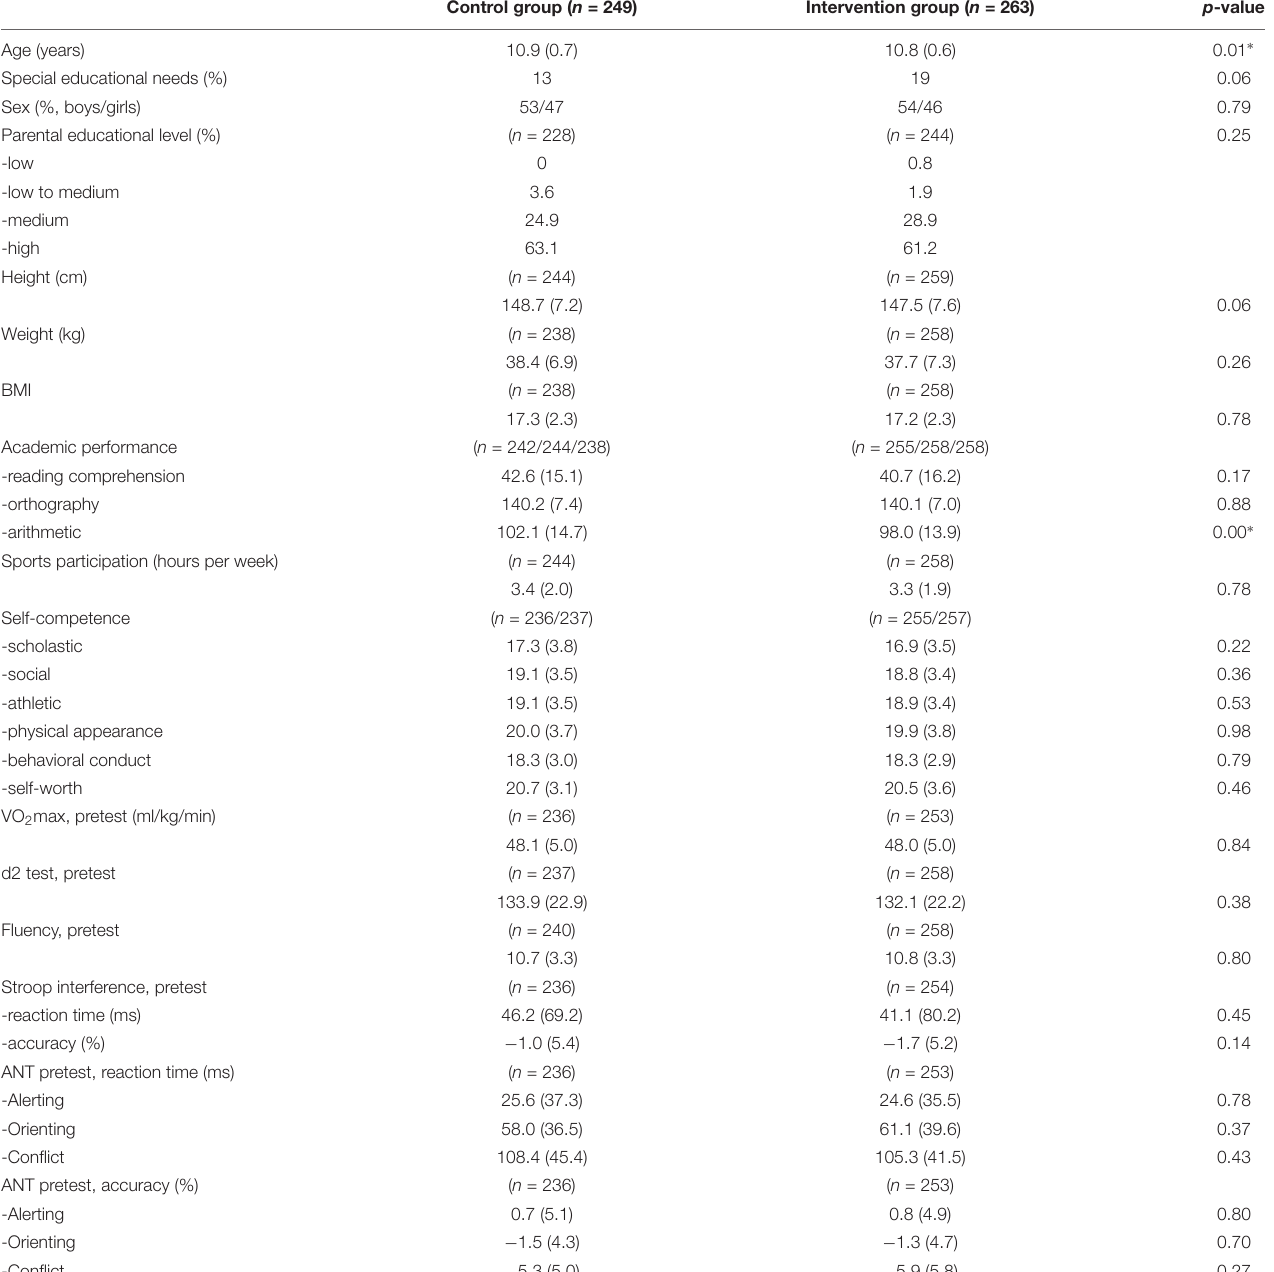
TABLE 1 | Descriptive characteristics (means and standard deviations) and group